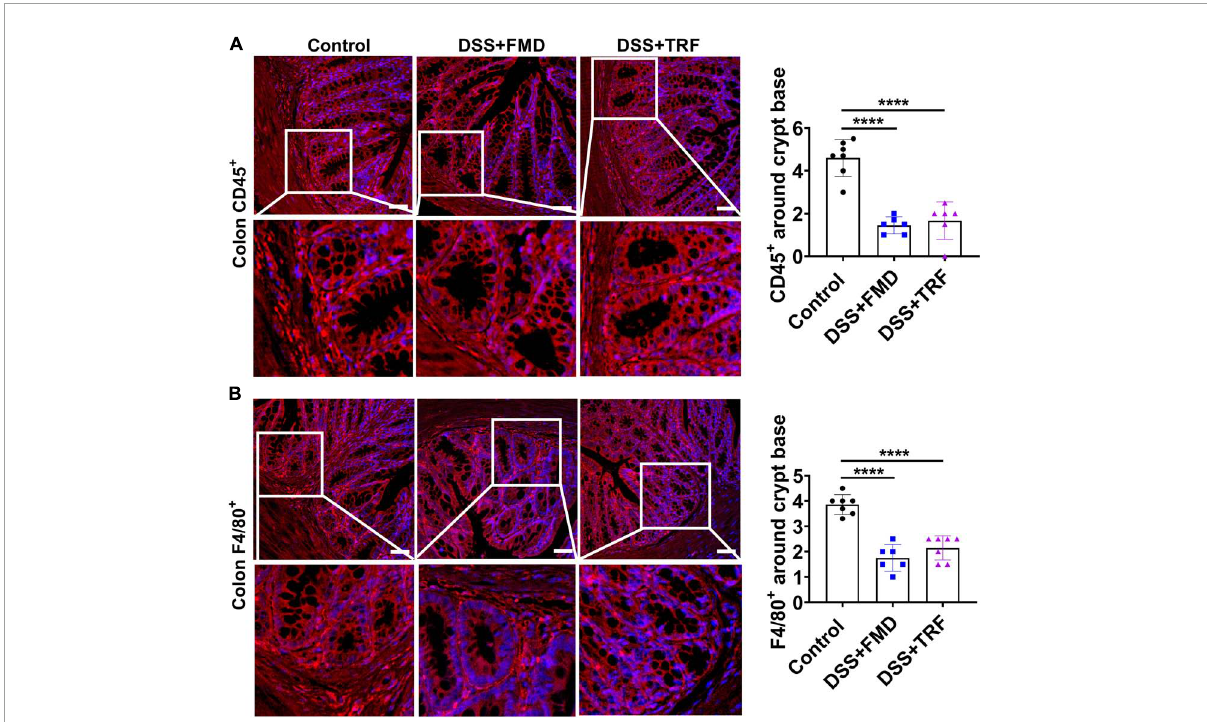
FIGURE5 TRF reduces the infiltration of leukocytes and macrophages around the crypt base in the lamina propria of colon. (A) Representative images of CD45 + immunofluorescent staining (red color) using colon sections. The nuclei were stained with DAPI (blue color). Quantitation of CD45 + cells around the crypt base is shown on the right ( n = 6 to 7 for each group). (B) Representative images of F4/80 + immunofluorescent staining (red color) in the colon. The nuclei were stained with DAPI (blue color). Quantitation of F4/80 + cells around the crypt base is shown on the right ( n = 6 to 7 for each group). Data are presented as mean ± SEM; **** P < 0.0001. The images were taken at 20 X magnification. Scale bar: 50 µ m.